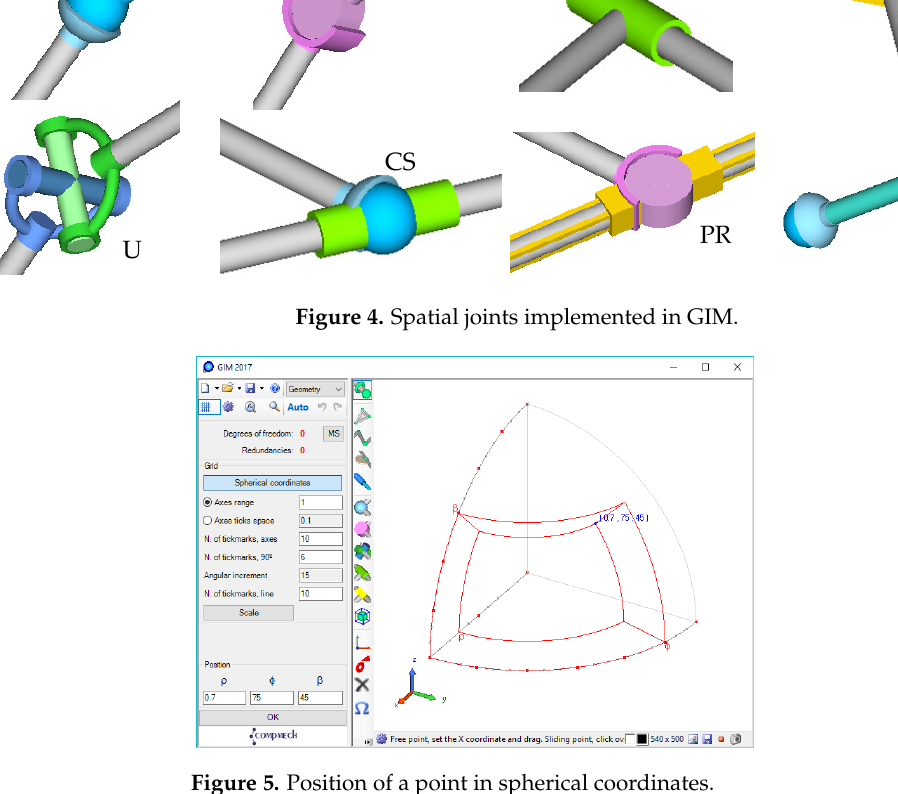
Figure 6. Main kinematic results: Trajectories, velocities, and accelerations for given inputs. Using this computation module, apart from having at hand the numerical results of the proposed problem (as a mechanism calculator), students can corroborate the relevant theoretical concepts studied during lectures. Some examples are shown in Figure 7: •